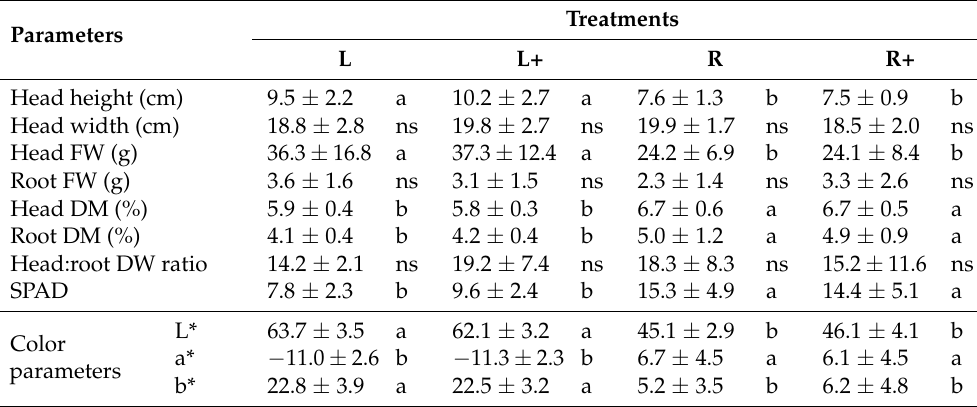
Table 1. Morpho-biometric and physiological characteristics of plants in monoculture, and in intercropping treatments. Different letters (a, b) indicate significant differences ( p < 0.05) among treatments for each parameter, according to the Tukey’s Honest Significant Difference (HSD) test. ns = not significant differences.